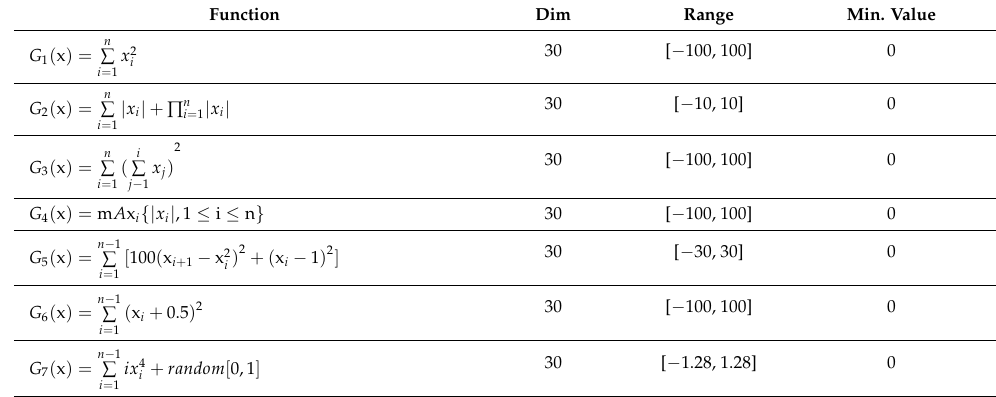
Table 2. Unimodal Benchmark Functions.